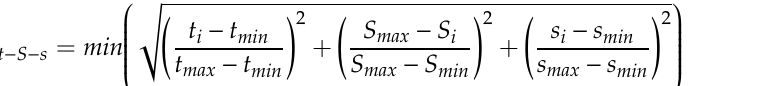
Figure 6. Hourly global irradiance ( a ) and wind velocity ( b ) in Palermo (Italy).